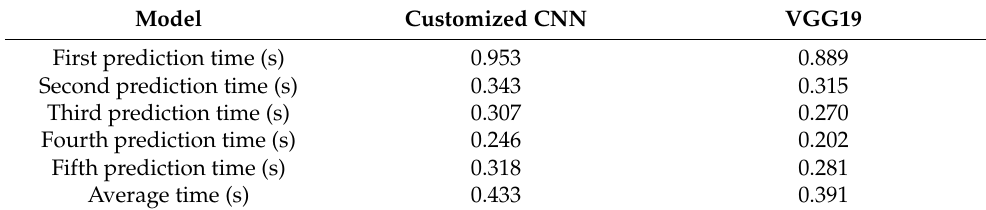
Table 5. Prediction times of the Customized CNN and VGG19